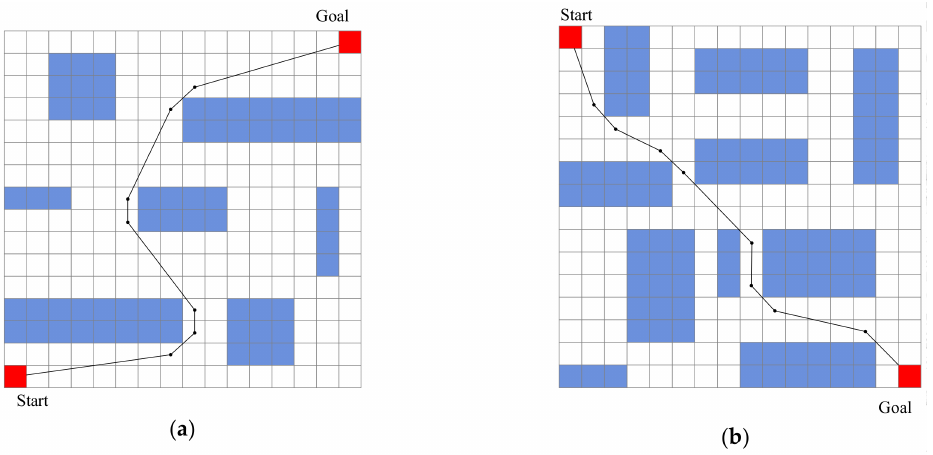
Figure 21. Collision-free shortest paths in environments. ( a ) Environment 1; ( b ) Environment 2.